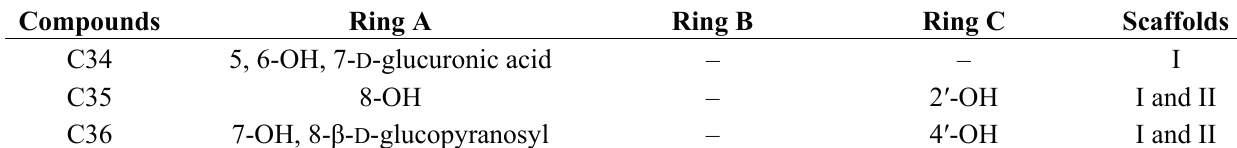
Table 2. 7,8-DHF and 36 di-hydroxy flavonoid derivatives with corresponding energies obtained from docking with TrkB-D5 using AutoDock program. BE e Estimated binding free energy in kcal mol − 1 ; K i Inhibitory constant in micro-molar; IME e Final